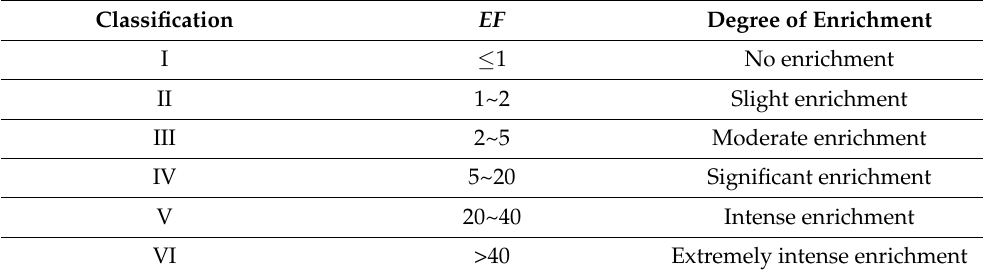
Table 1. Classification of enrichment factor ( EF ).